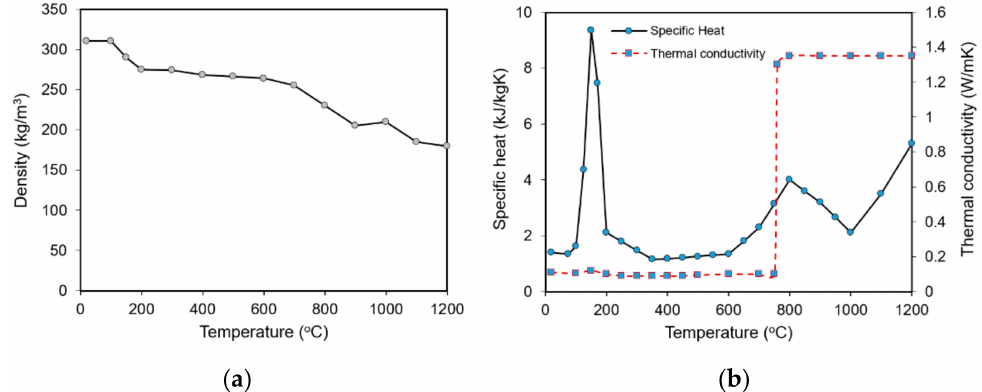
Figure 6. Material properties of insulation at high temperature: ( a ) Density; ( b ) Specific heat and thermal conductivity.